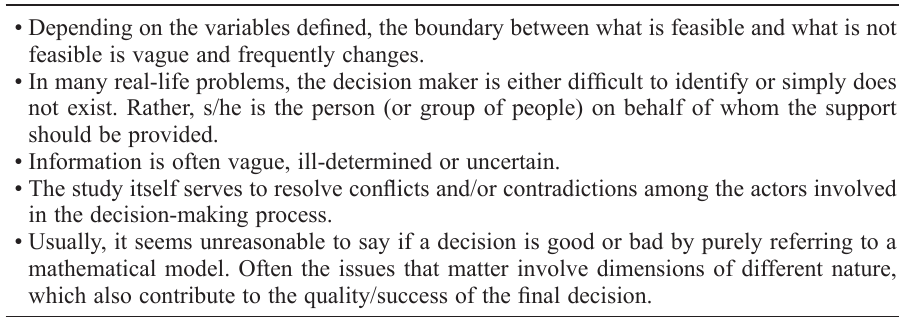
Table 1. Main features of the MCDA approach